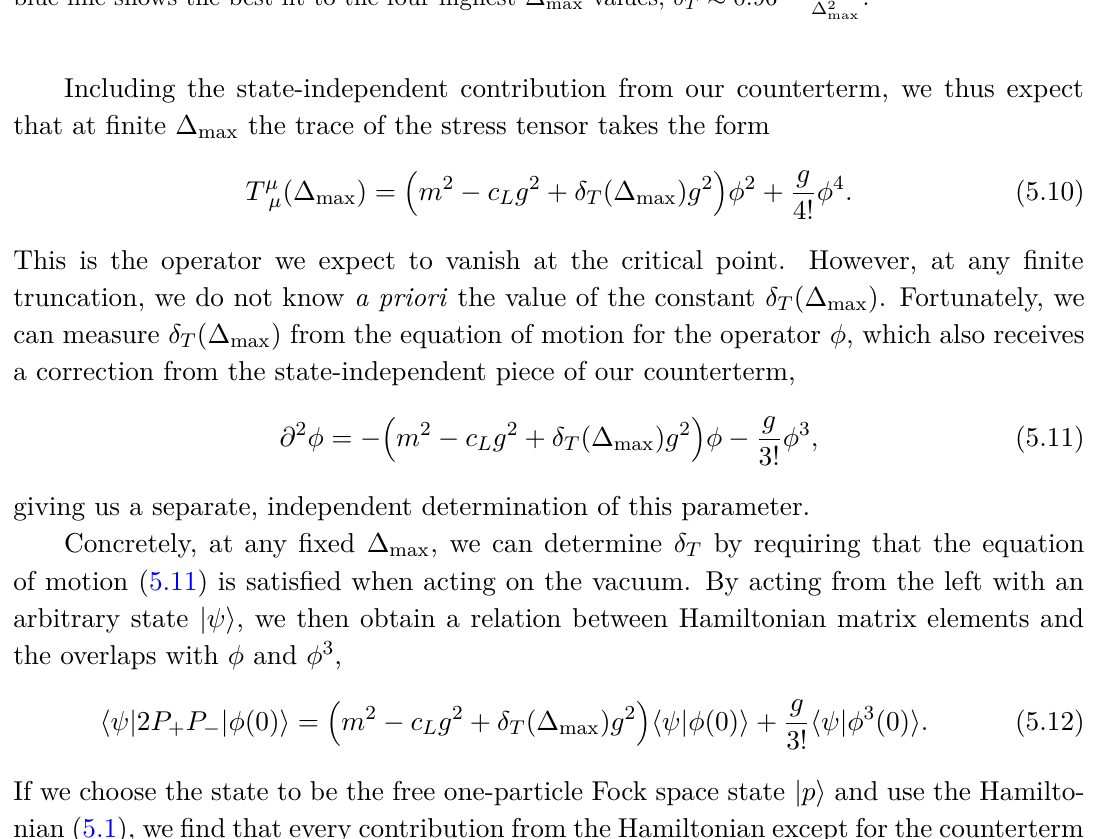
Figure 12 . Measured values of blue line shows the best fit to the four highest ∆